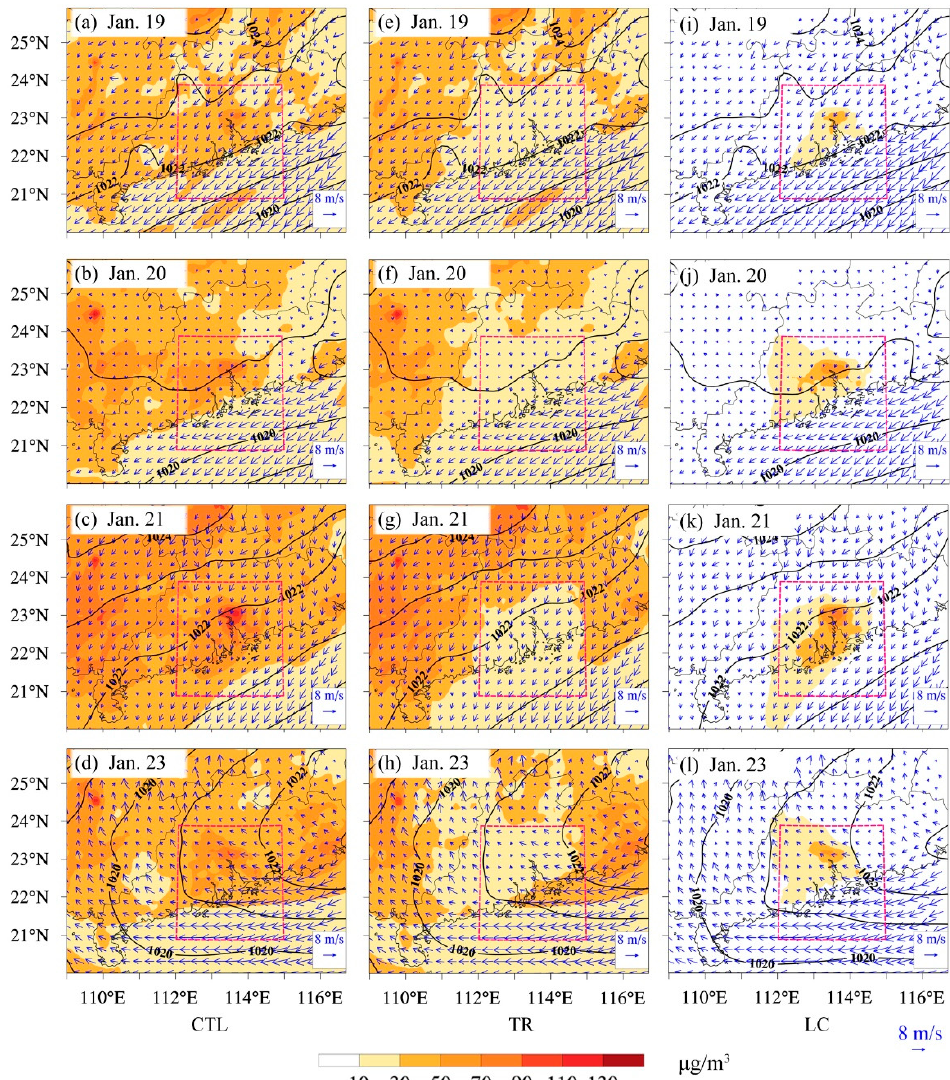
Figure 10. The simulation results of the daily average near-surface PM 2.5 concentration (shaded; unit: µ g / m 3 ), 10-m wind field (blue vector; unit: m / s) and sea level pressure (black contour; unit: hPa) from 19 to 21 January and on 23 January. ( a ) to ( d ) are for the CTL experiment, ( e ) to ( h ) are for the TR experiment, and ( i ) to ( l ) are for the LC experiment (the pink dotted box refers to the emissions control region).